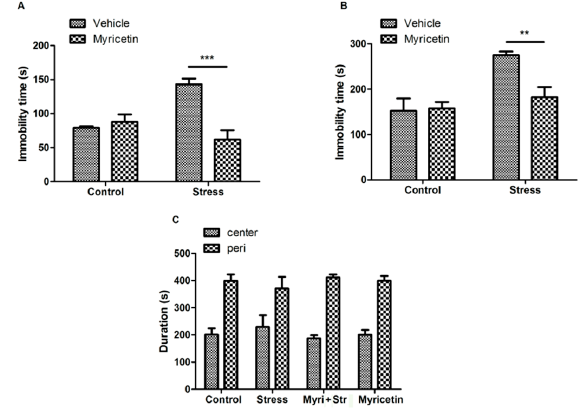
Figure 1. Effects of myricetin on repeated restraint stress-induced depressant-like behavior in mice. ( A ) Immobility time during the forced swimming test showing that myricetin treatment reversed the increase in the immobility time of the mice subjected to repeated restraint stress. Regular two-way Analysis of Variance (ANOVA), drug(myricetin) × treatment(stress) interaction F (1,23) = 19.44, p < 0.001; significant drug variation F (1,23) = 12.68, p < 0.01, Boferroni post-test, *** p < 0.001 significant difference between groups; ( B ) immobility time during the tail suspension test showing that myricetin treatment reversed the increase in the immobility time of the mice subjected to repeated restraint stress. Regular two-way ANOVA, drug(myricetin) × treatment(stress) interaction F (1,23) = 6.85, p < 0.05; significant treatment variation F (1,23) = 15.28, p < 0.001; significant drug variation F (1,23) = 5.41, p < 0.05, Boferroni post-test, ** p < 0.001 significant difference between groups; and ( C